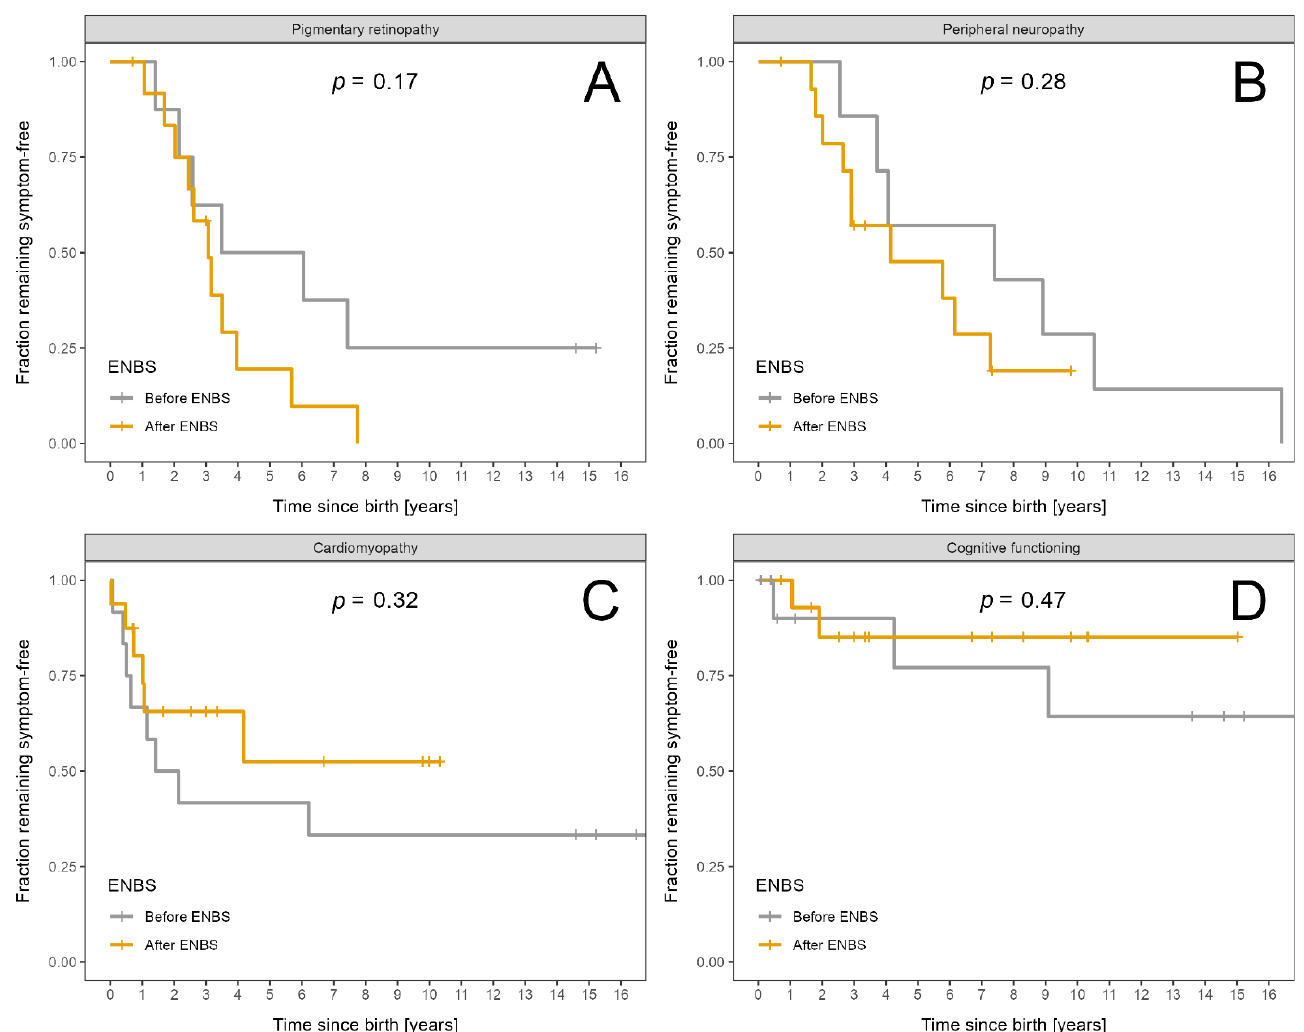
Figure 4. Fraction of LCHADD/MTPD patients remaining symptom free: Patients diagnosed before ENBS ( n = 12) are shown as grey and patients diagnosed after ENBS ( n = 16) as orange lines, respectively. ( A ) Absence of pigmentary retinopathy. ( B ) Absence of peripheral neuropathy. ( C ) Absence of cardiomyopathy. ( D ) Absence of intellectual disability. Kaplan–Meier estimator was used; p designates significance of difference between the cohorts.